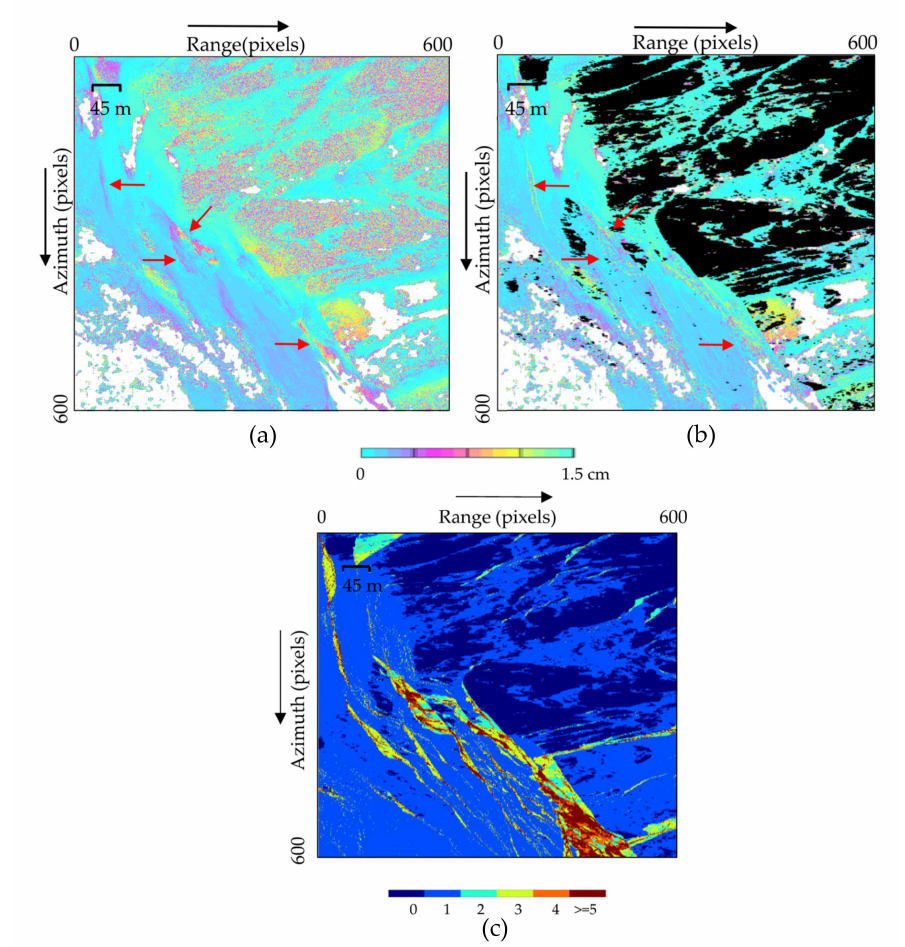
Figure 10. Layover topographic correction: Mount Currie, TSX staring spotlight interferogram (24 July–4 August 2017). ( a ) Conventional method; ( b ) layover corrected with shadow mask; ( c ) number of topographic solutions. Red arrows show the false motion areas, which have been removed after layover